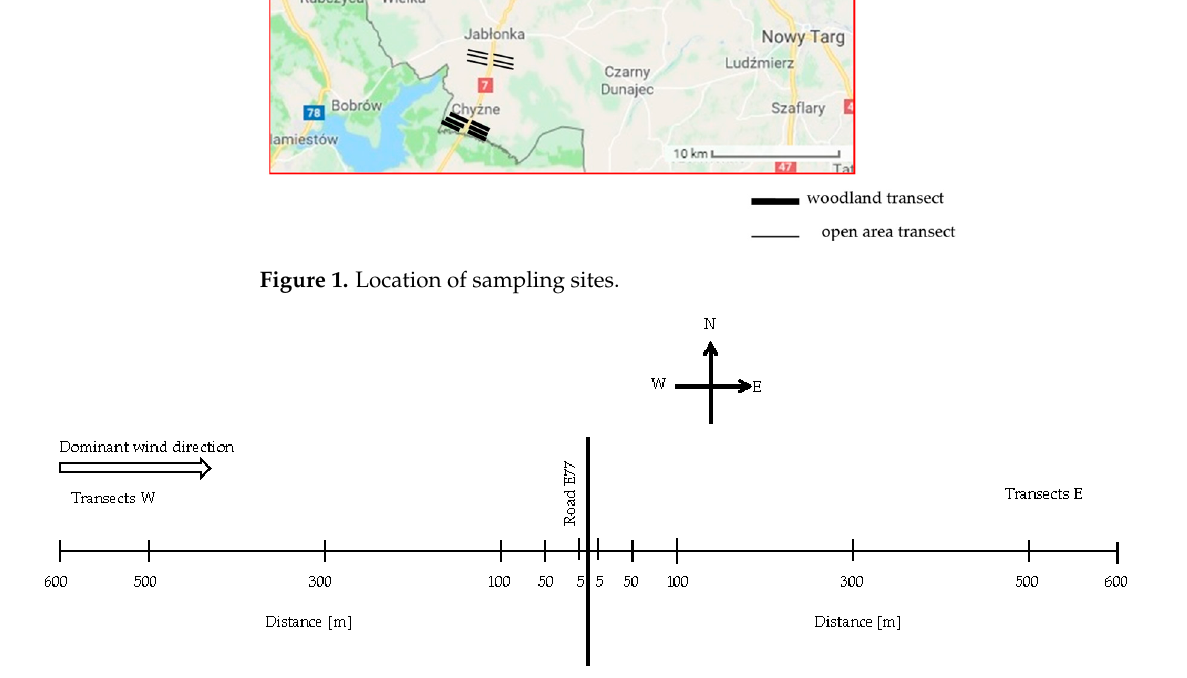
Figure 2. Scheme of sampling transect.